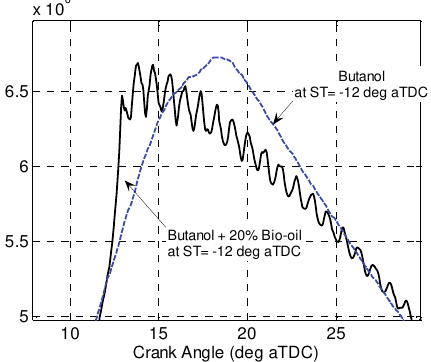
Fig. 9. Zoom on in-cylinder pressure vs. crank angle